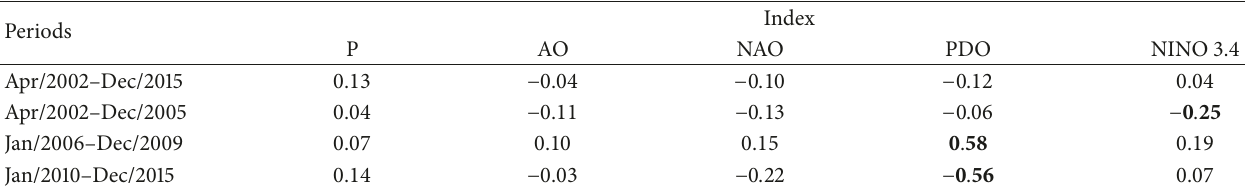
Table 3: Correlation coefficients between TWS/precipitation and teleconnection indices.